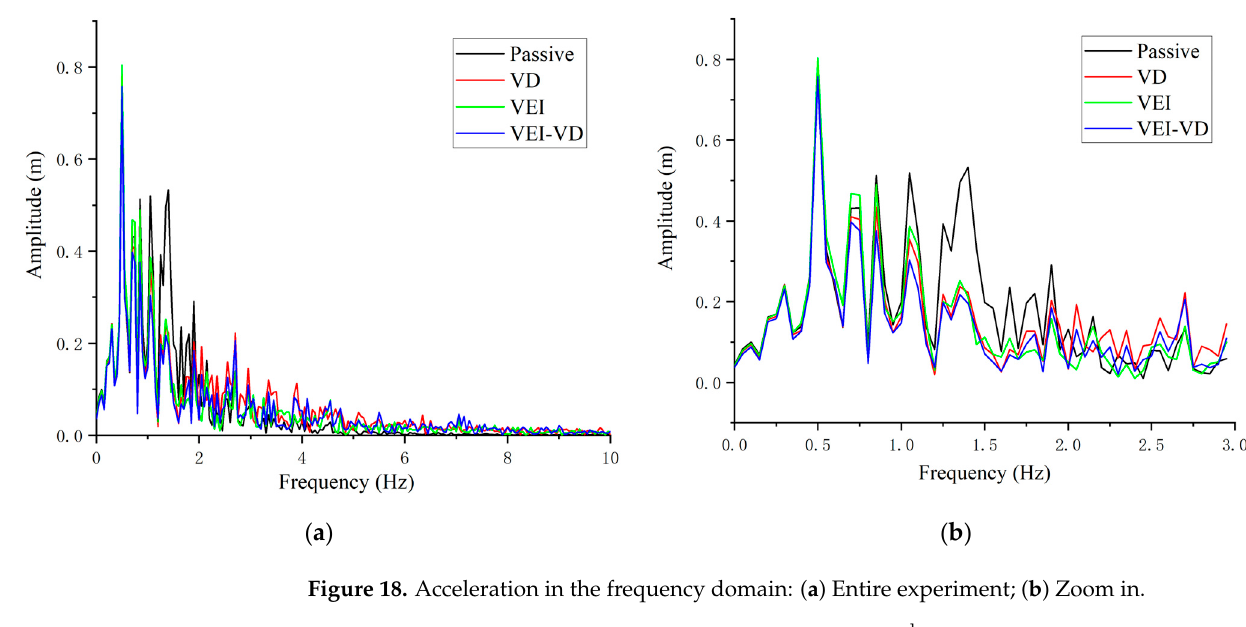
Figure 17. Seat acceleration in the time domain: ( a ). Entire experiment; ( b ) Zoom in.